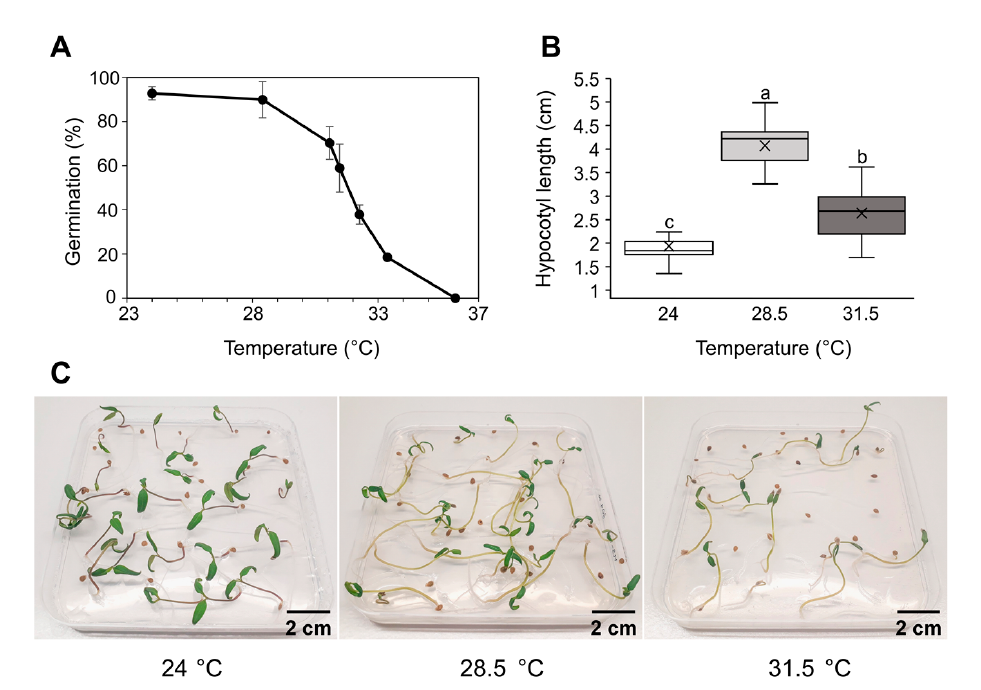
Figure 1. Effect of elevated temperatures on tomato seed germination and seedling development. Following stratification, tomato seeds were exposed for 8 days to a set of rising temperatures after which the germination rate was determined ( A ), hypocotyl lengths were measured ( B ) and seedlings’ phenotype was documented ( C ). Data in ( A ) represent the average of three biological replicates, each consisting of 25–30 seeds. For ( B ), data are represented as boxes indicating the lower and upper quartile, while the means and medians of 20 seedlings are denoted with a horizontal line and a cross in the box, respectively. Different letters indicate a significant difference at p < 0.05 (Tukey’s test). The scale bar is 2